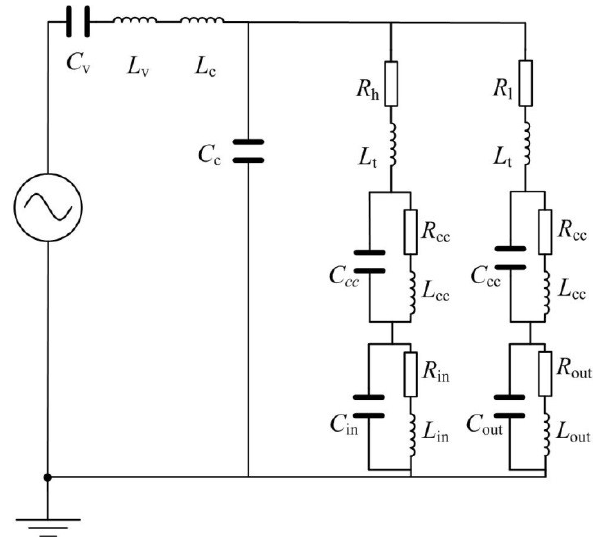
Figure 7. Equivalent circuit diagram when the input voltage is in the negative half-period.